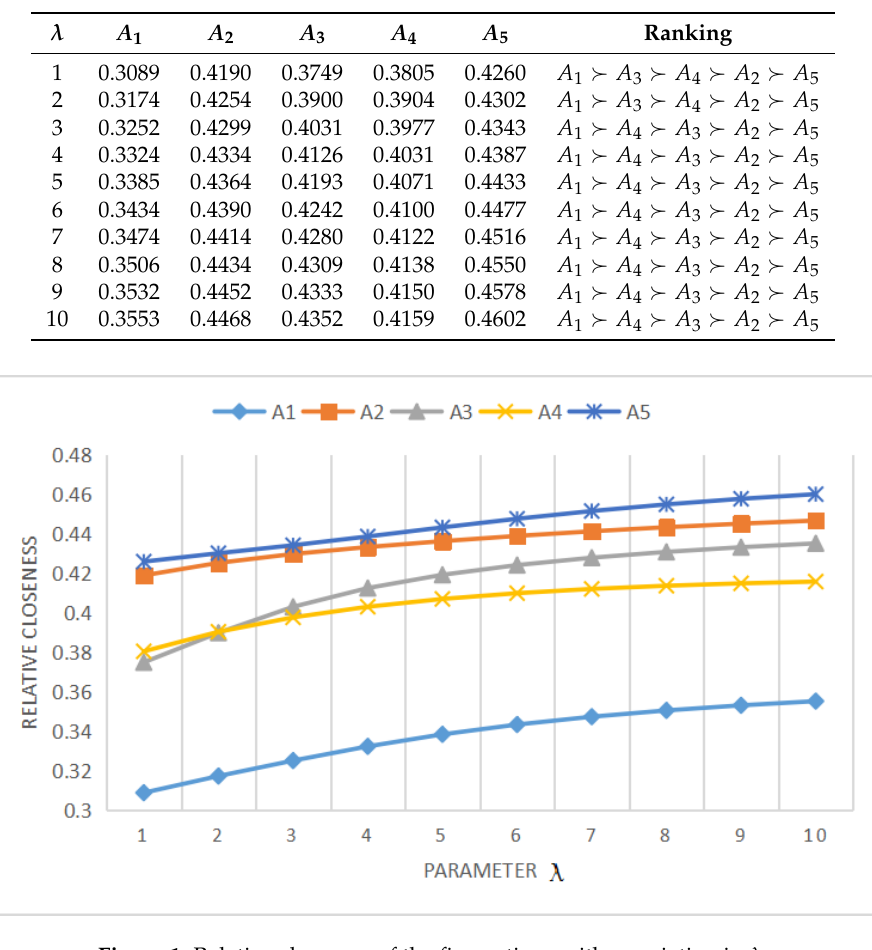
Figure 1. Relative closeness of the five nations with a variation in λ